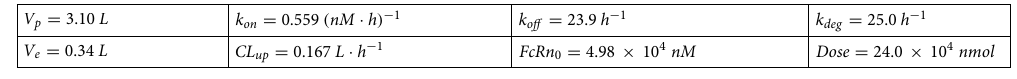
Table 1. The parameter set employed for modelling the system in Eq.